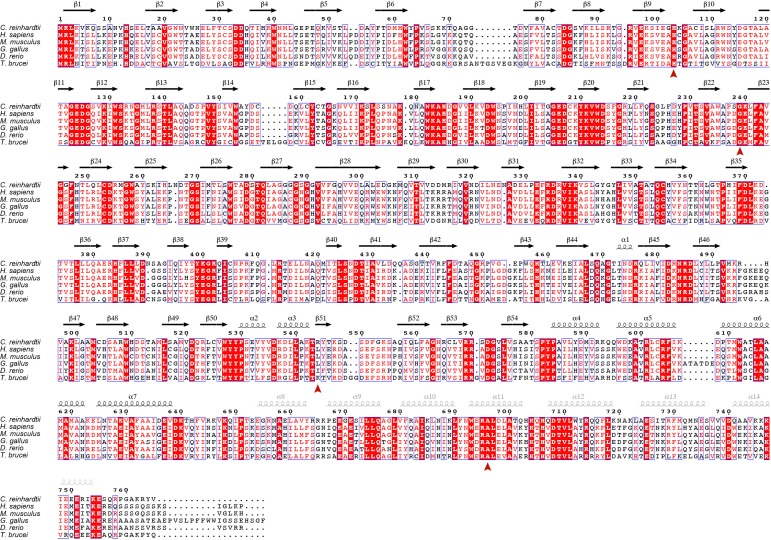
Sequence alignment between IFT80 proteins from various species.IFT80 sequences from six organisms were aligned using Clustal Omega (McWilliam et al., 2013), and the resulting aligment was visualized in ESPript (Robert and Gouet, 2014). Secondary structure elements derived form the structure of CrIFT80 presented in this work are shown in black above the alignment. Predicted secondary structure elements for the most C-terminal region for which no electron density was observed in the crystal are shown in grey. Red arrowheads below the alignment show the positions of mutated residues in ciliopathy patients with alterations in IFT80.